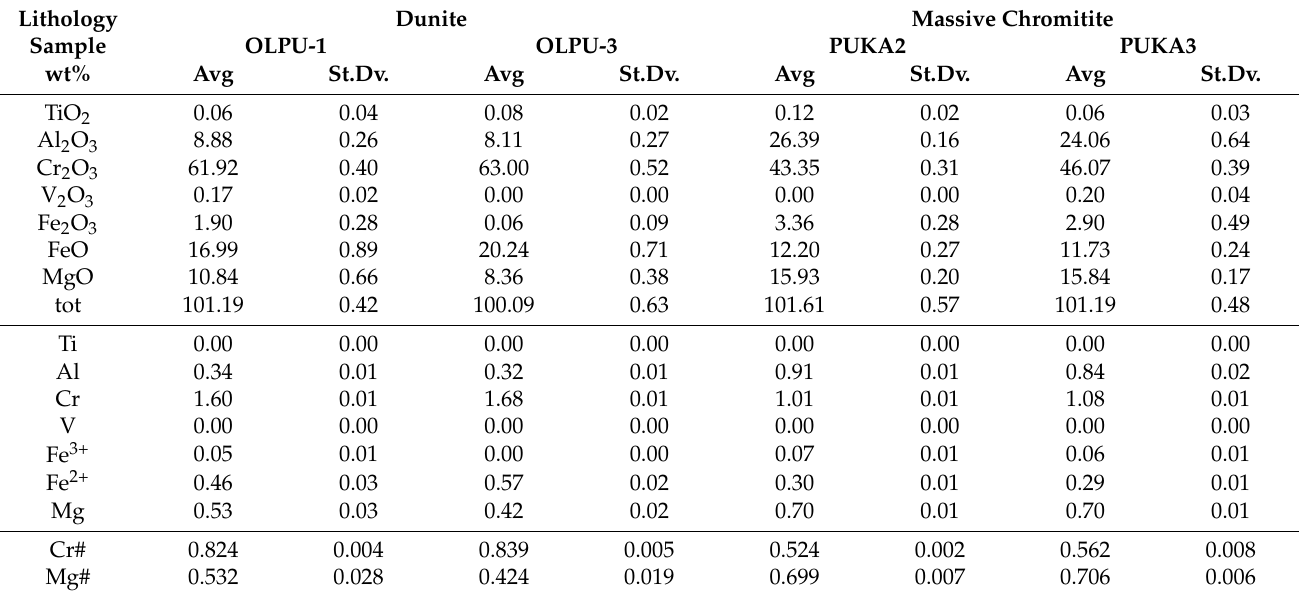
Table 1. Major and minor elements average composition and standard deviation of chromite cores